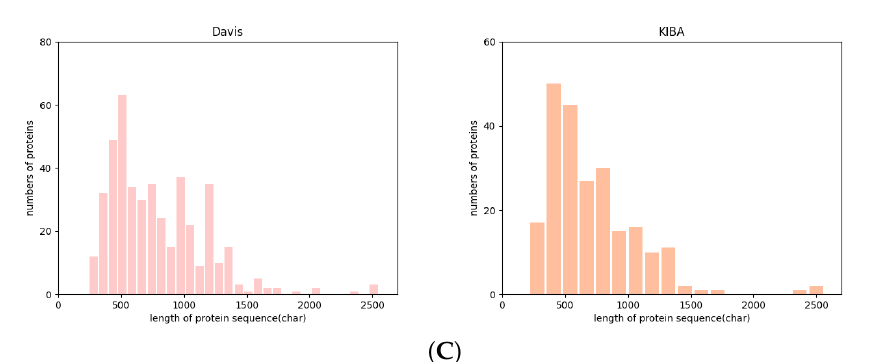
Figure 3. Data length distribution of Davis and KIBA data sets. ( A ) Represents the length distribution of SMILES. ( B ) The number in the middle represents the length distribution of Morgan fingerprints, and ( C ) represents the length of the distributed protein